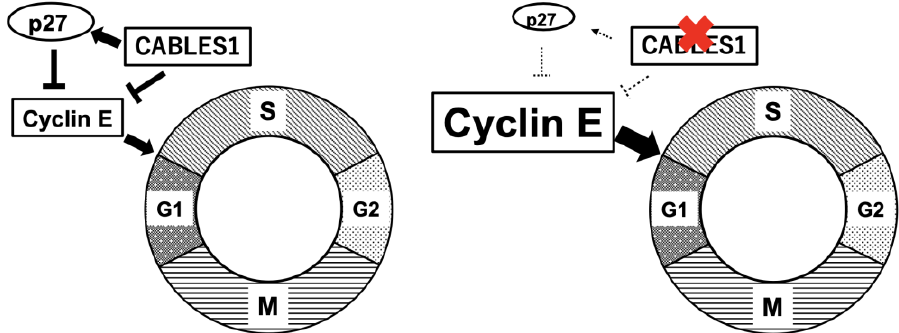
Figure 1. Cell-cycle regulators in normal corticotroph cells ( left panel ) and corticotroph tumor cells ( right panel ). The negative cell-cycle regulator Cdk5 and ABL enzyme substrate 1 (CABLES1) inhibit cyclin E directly and indirectly, resulting in the suppression of the cell cycle. However, CABLES1 is completely absent in more than half of human corticotroph tumors. Cyclin E overexpression, which correlates with low expression levels of the cell-cycle inhibitor tumor protein 27Kip1 (p27) may stimulate the cell cycle in tumor cells.